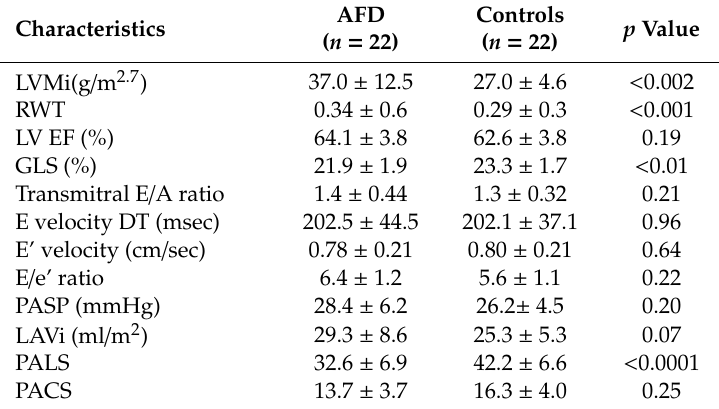
Table 2. Echo-Doppler data of the study